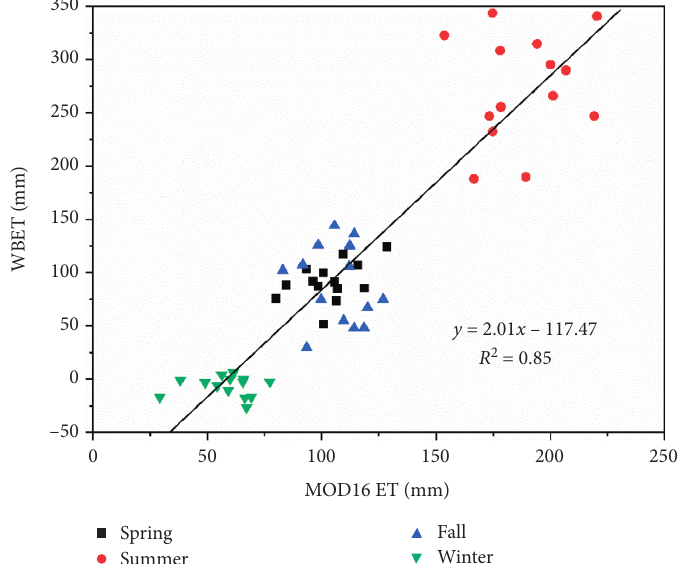
Figure 3: Scatter between evapotranspiration obtained by water balance (WBET) and MOD16 ET data at seasonal